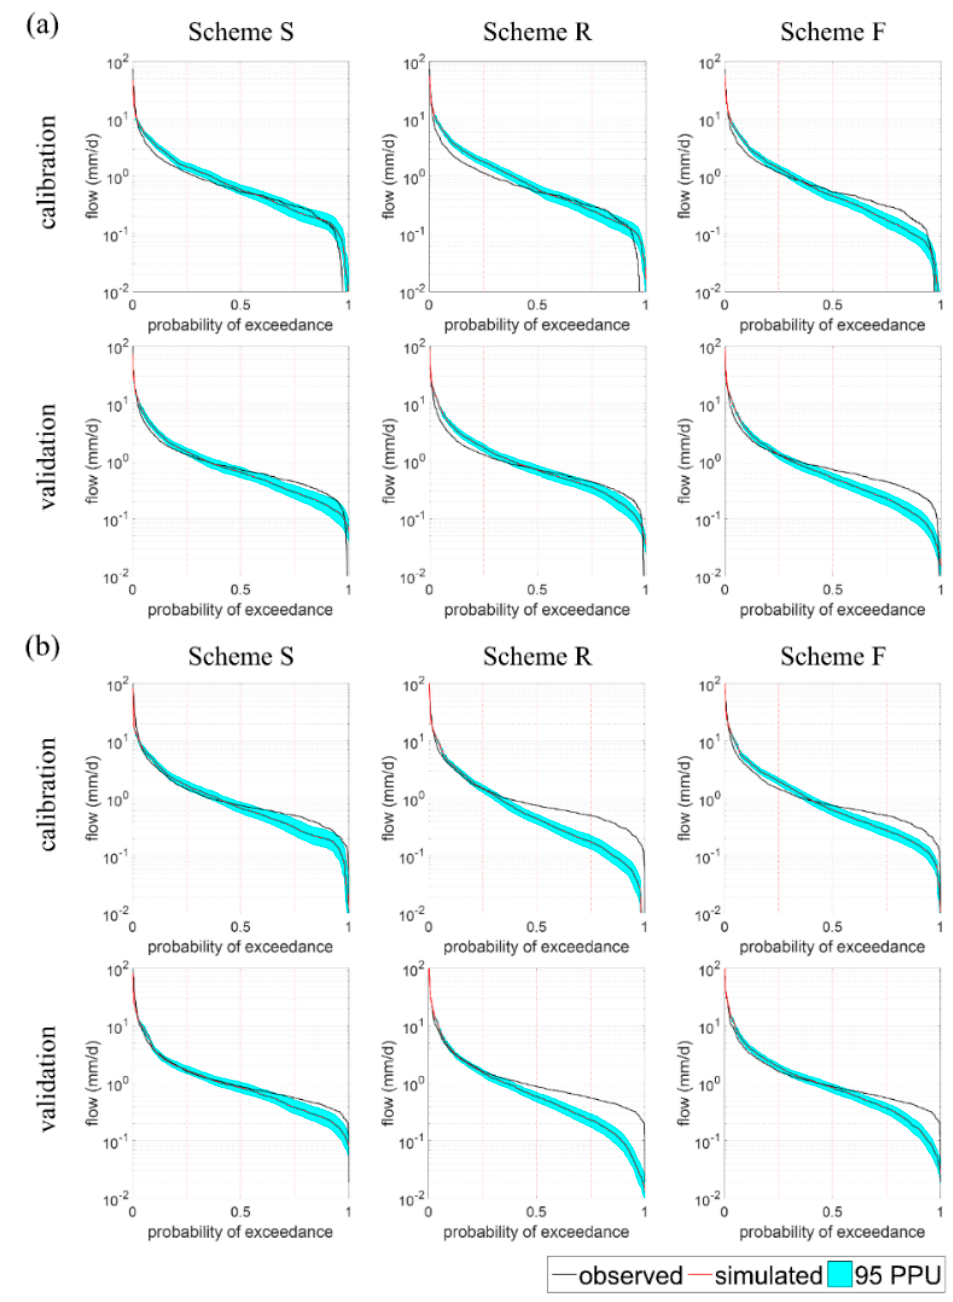
Figure 9. Flow duration curves during the calibration period (2016–2019) and validation period (2012–2015) for ( a ) Hapcheon Dam watershed and ( b ) Namgang Dam watershed.